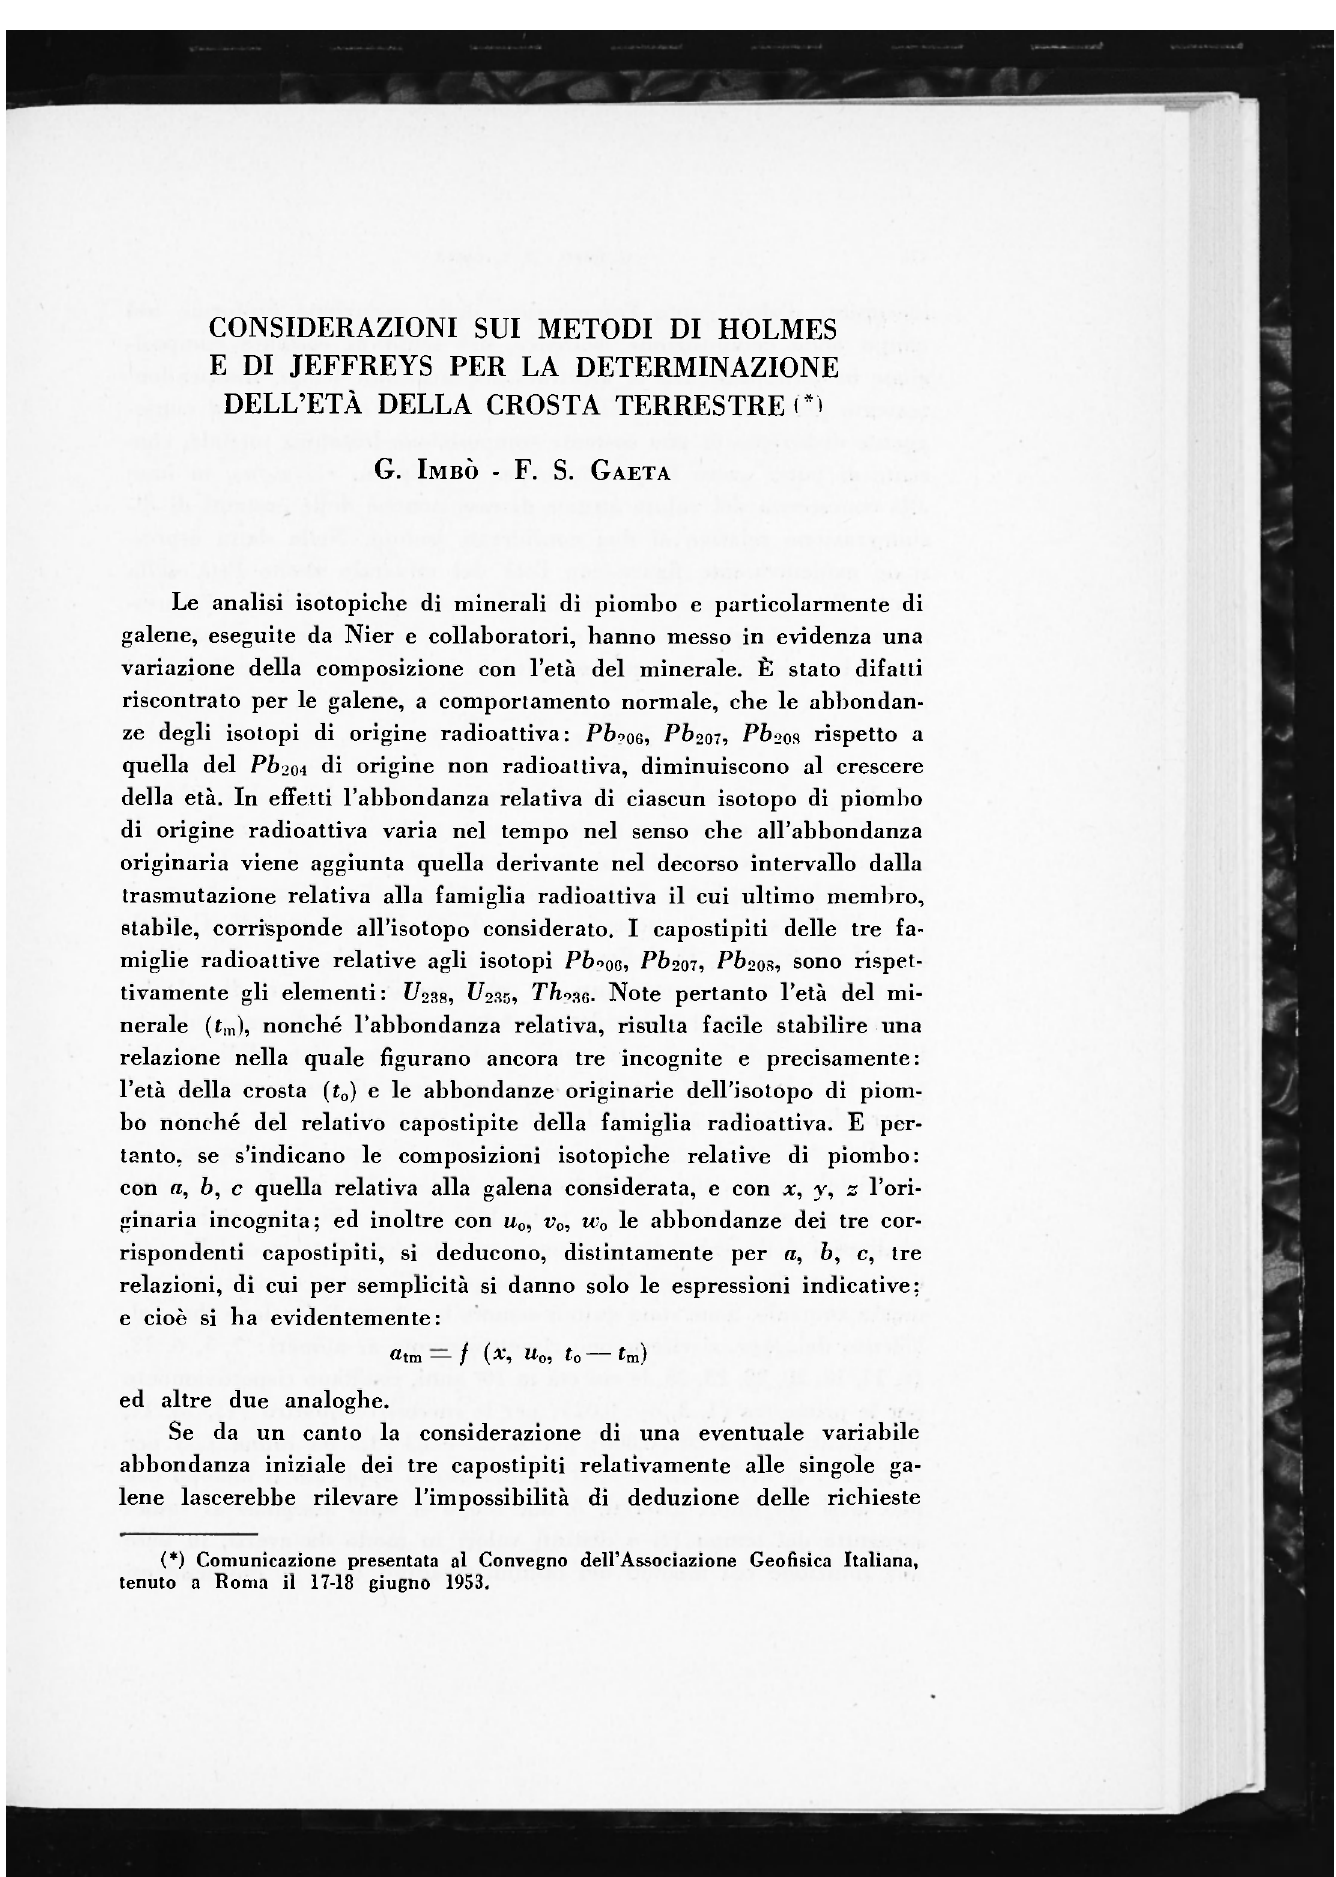
figurano ancora tre incognite e precisamente